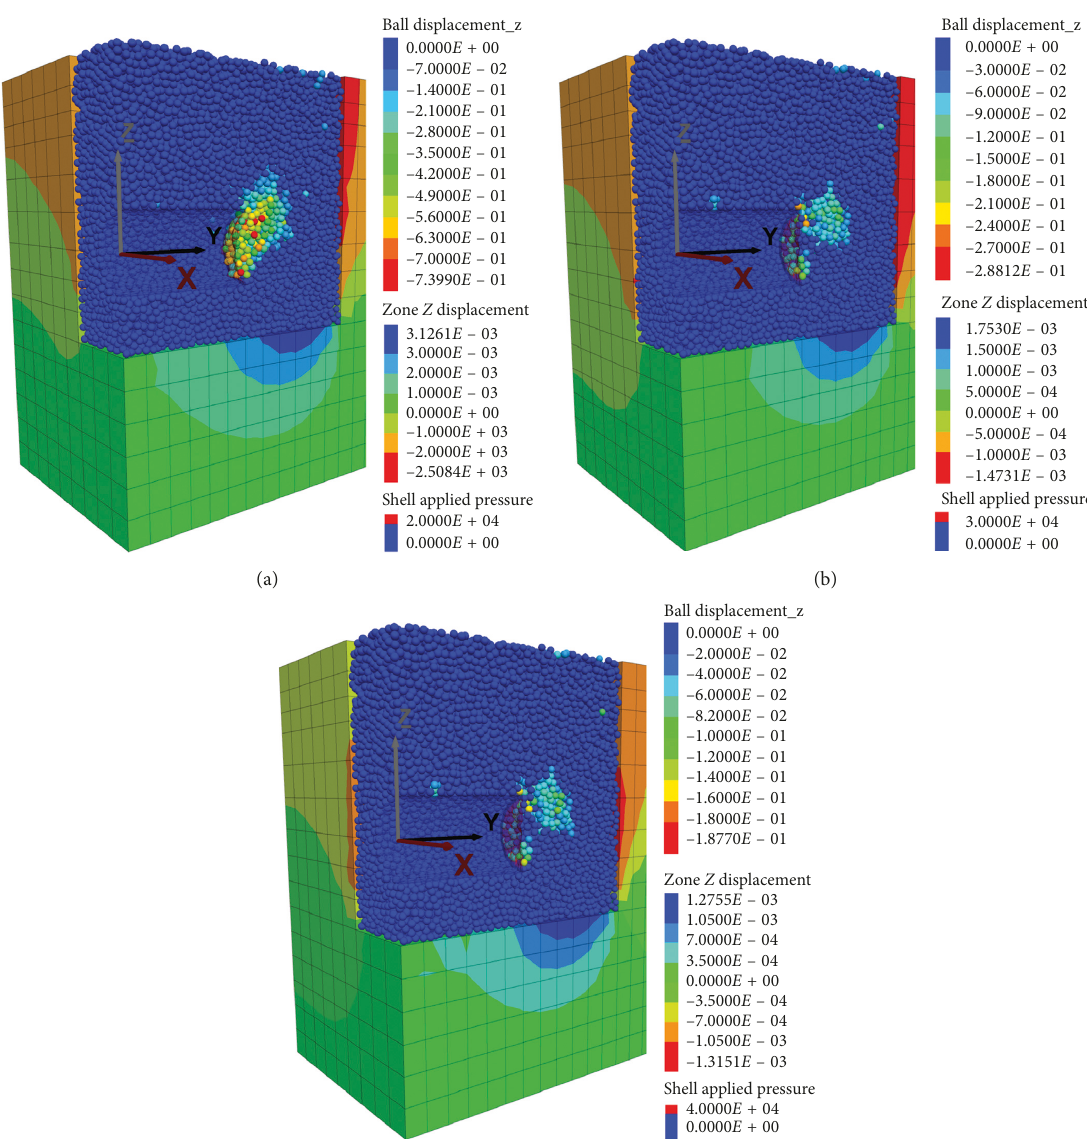
Figure 16: Soil deformation of 20 kPa, 30 kPa, and 40 kPa supporting